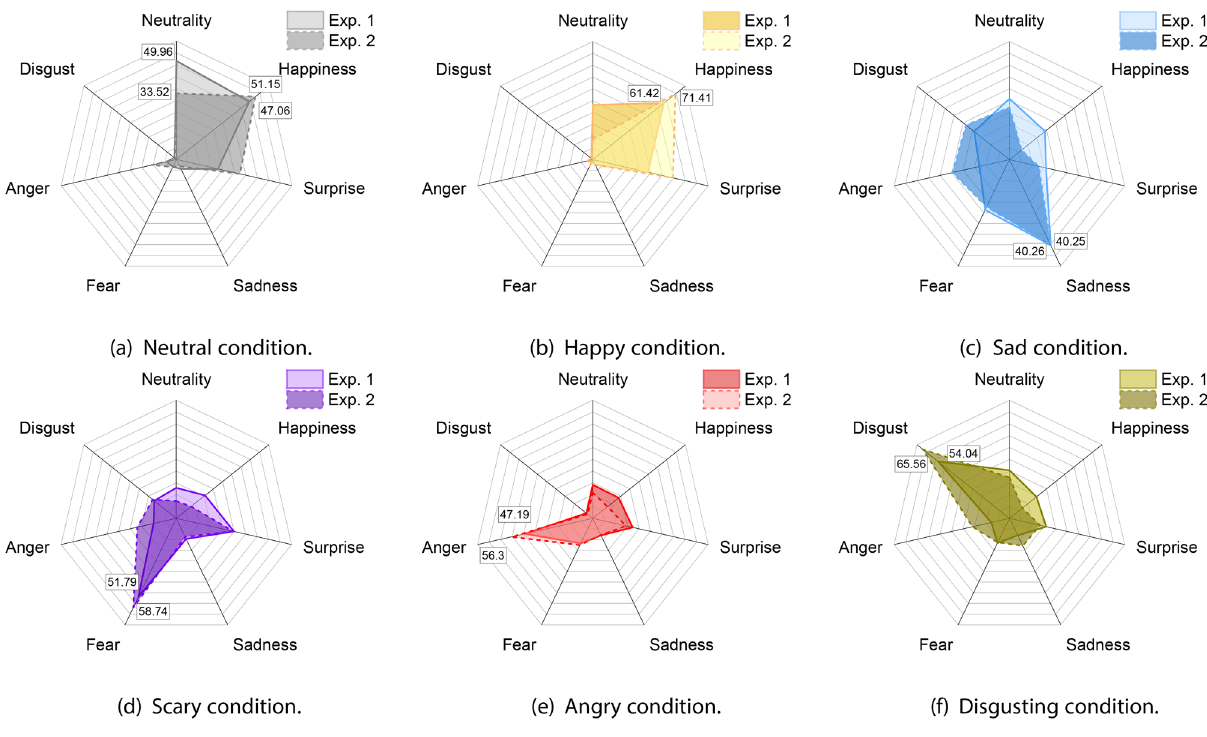
Figure 4. Comparison between the emotional rates in Exp. 1 and Exp.